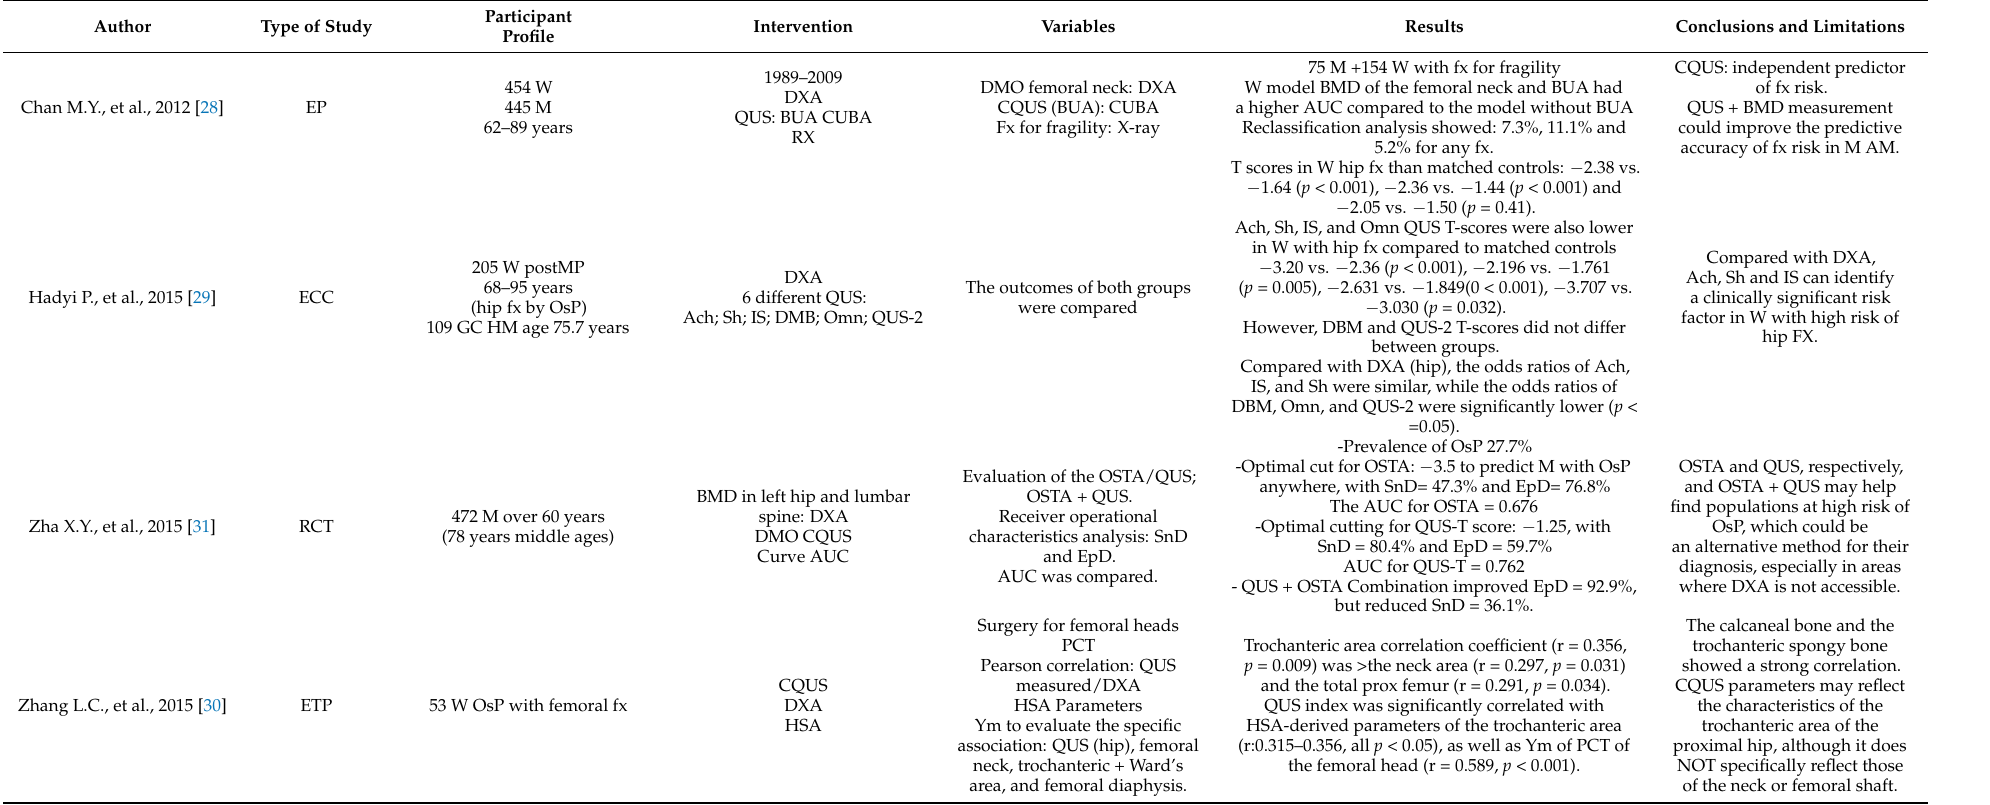
Table 2. Characteristics of the studies